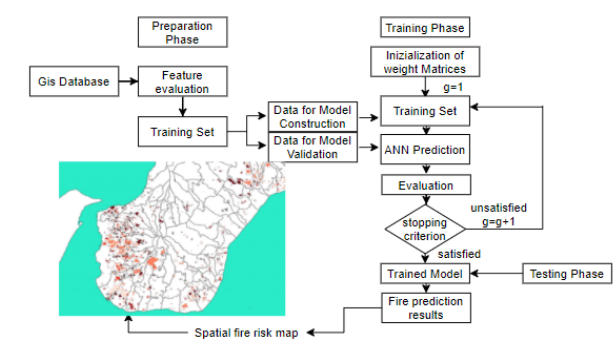
Figure 16. GIS implementation